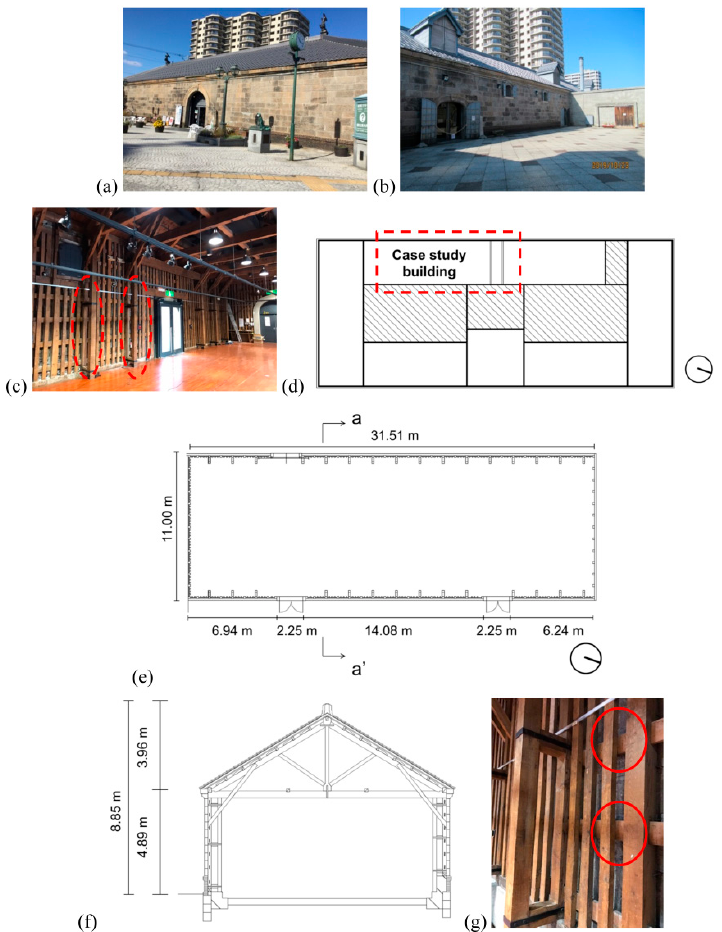
Figure 2. Otaru warehouse complex: ( a ) south elevation, ( b ) the studied warehouse, ( c ) interior view, ( d ) site plan, ( e ) plan of the studied warehouse, ( f ) a–a’ section and ( g ) nogging coupling stud and